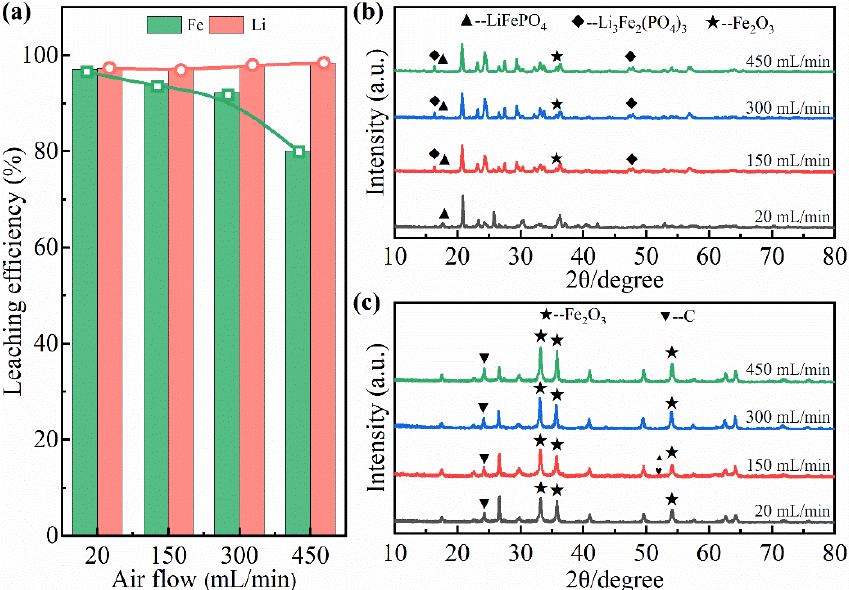
Figure 11. Leaching performance of cathode materials obtained at different air flow under the leaching conditions of 1.0 M H 2 SO 4 , S/L = 25 g/L, 70 °C, and 60 min. ( a ) Leaching efficiencies of Fe and Li; ( b ) XRD patterns of calcined cathode materials; ( c ) XRD patterns of sulfuric acid leaching residue.